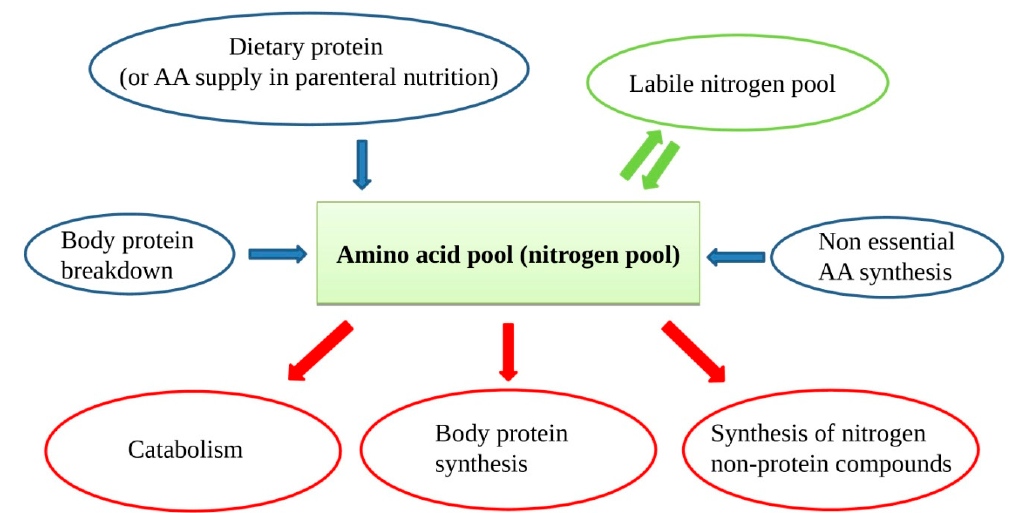
Figure 1. The amino acid (AA) pool contains AAs arising from dietary source, protein breakdown, non-essential AAs (NEAAs) from liver synthesis, and labile nitrogen pool. As the body cannot store proteins, there is a continuous AA turnover with a constant AA input balancing the AA output.